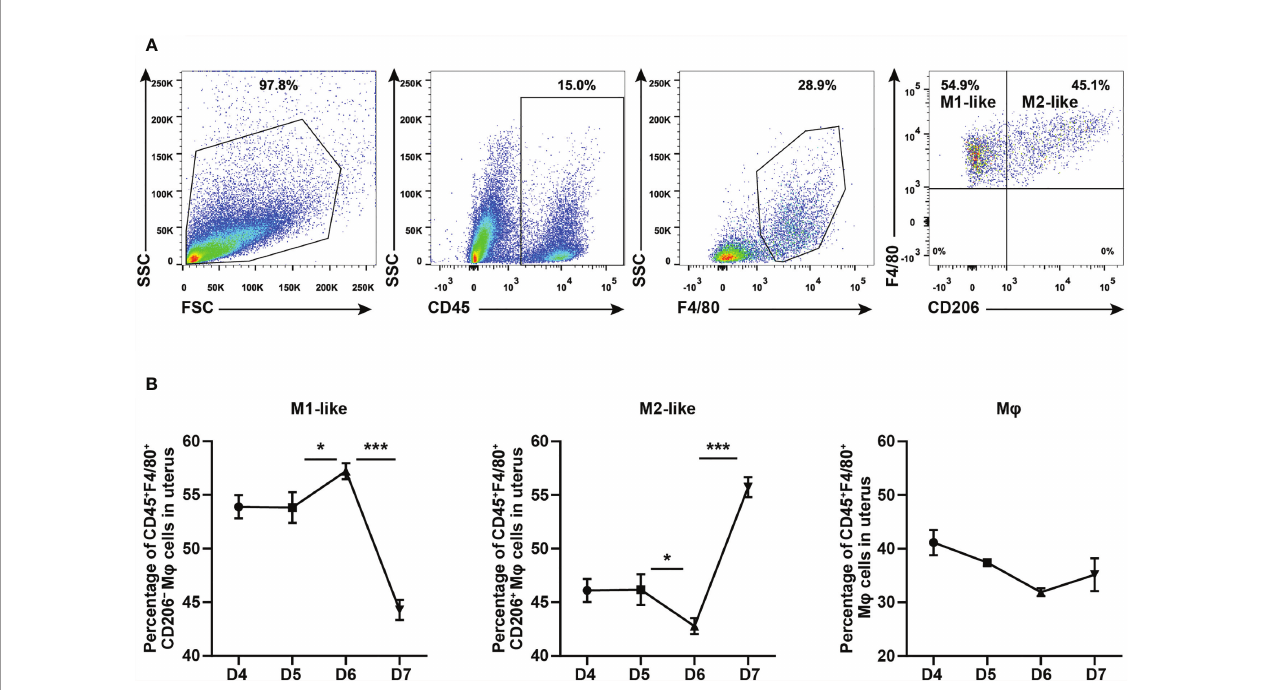
FIGURE 1 | FCM analysis of dynamic changes of M1-like and M2-like uterine macrophages during the peri-implantation period in mice. (A) Gating strategy used to identify uterine M1-like macrophages (CD45 + F4/80 + CD206 − ) and M2-like macrophages (CD45 + F4/80 + CD206 + ) in pregnant mice. FSC vs SSC gating was used to clean up the debris and dead cells. CD45 + represents leukocyte; F4/80 + represents macrophages; CD206 − and CD206 + represent M1-like and M2-like uterine macrophages, respectively. (B) Dynamic changes of M1-like macrophages, M2-like macrophages and M j during peri-implantation period in mice (n ≥ 3). Error bars represent means ± SEM; two-tailed unpaired t-test, ns, not signi fi cant, *P < 0.05 or ***P < 0.001.